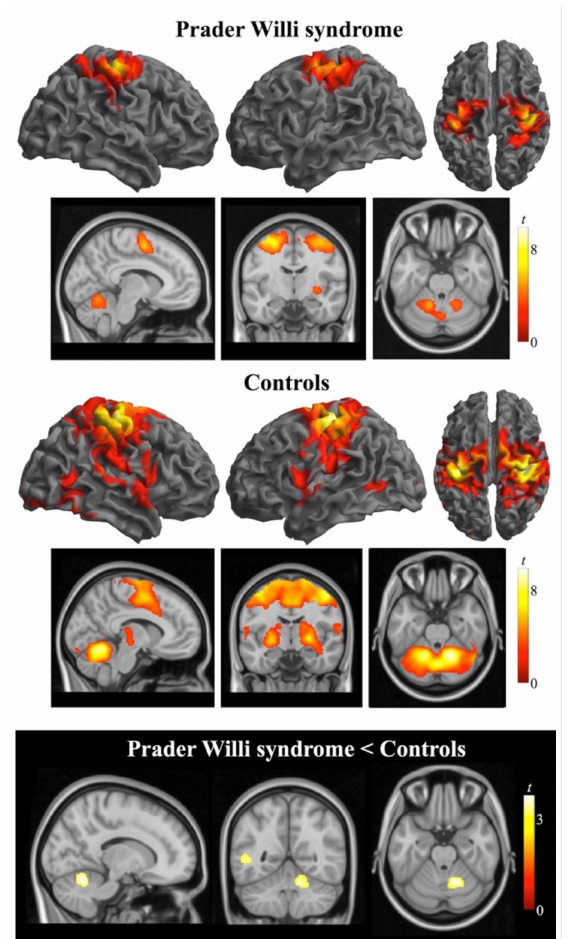
Figure 2. Brain activation (one sample t -tests) obtained during the bimanual anti-phase flexion- extension task in individuals with Prader Willi syndrome (top rows) and control subjects (mid rows). The brain views in the bottom row illustrate between-group differences in whole brain activation (two sample t -test). Activations are thresholded at p FWE -corrected < 0.05. Color bars represent t values. Right in axial and coronal views corresponds to the right